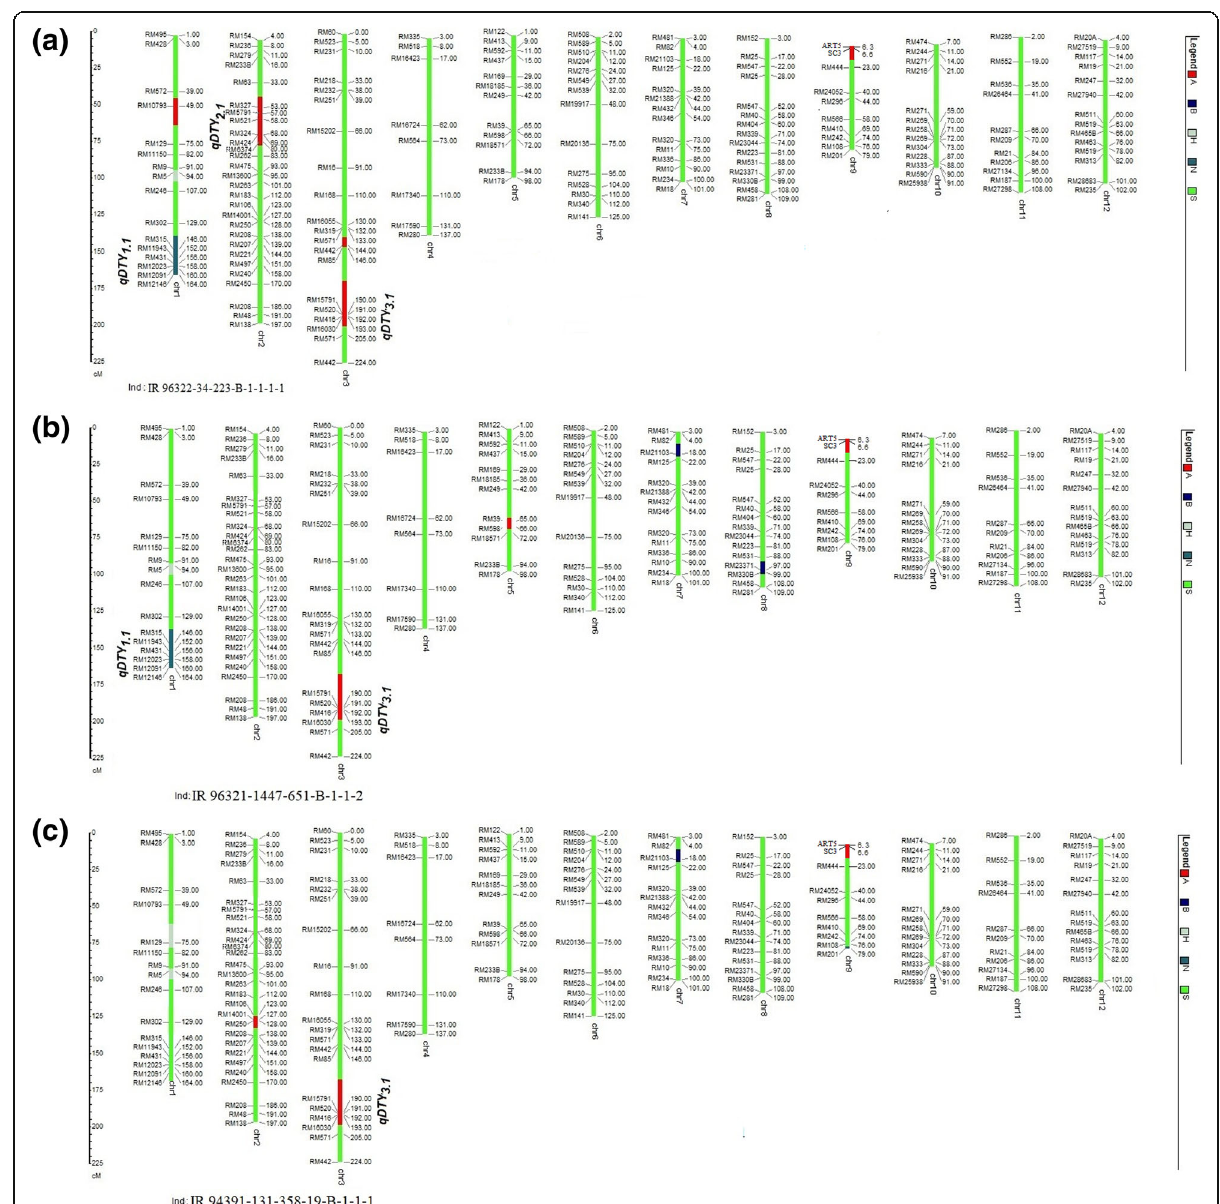
Fig. 2 Graphical representation of the background recovery of NILs ( a ) IR 96322-34-223-B-1-1-1-1 ( b ) IR 96321-1447-651-B-1-1-2 ( c ) IR 94391-131- 358-19-B-1-1-1 using molecular marker data was performed in Graphical Genotypes (GGT 2.0) software (Van Berloo 1999). Apo parent allele, N22 allele, Swarna-Sub1 allele, heterozygous allele and any other allele, were scored as ‘ A ’ , ‘ N ’ , ‘ S ’ , ‘ H ’ , and ‘ B ’ ,